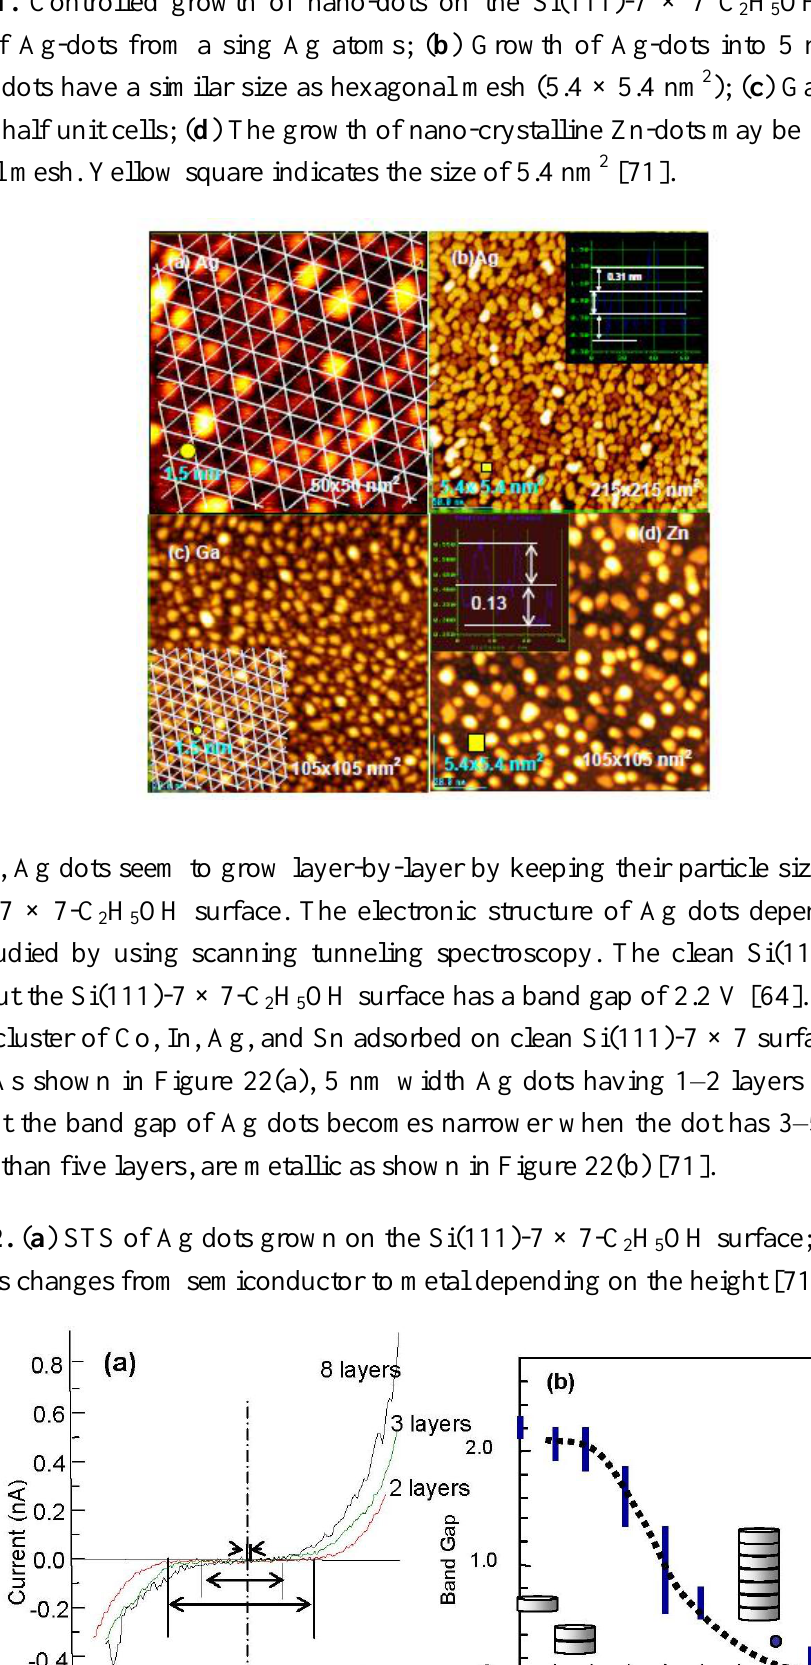
H OH surface; ( a ) 2 5